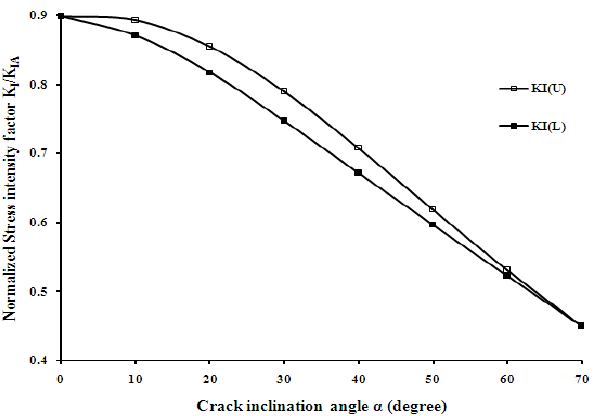
Figure 10: Effect of crack inclination angle α on K I for two parallel crack; a/W = 0.08, k = 0.75, S = 1.5 and B = 24.